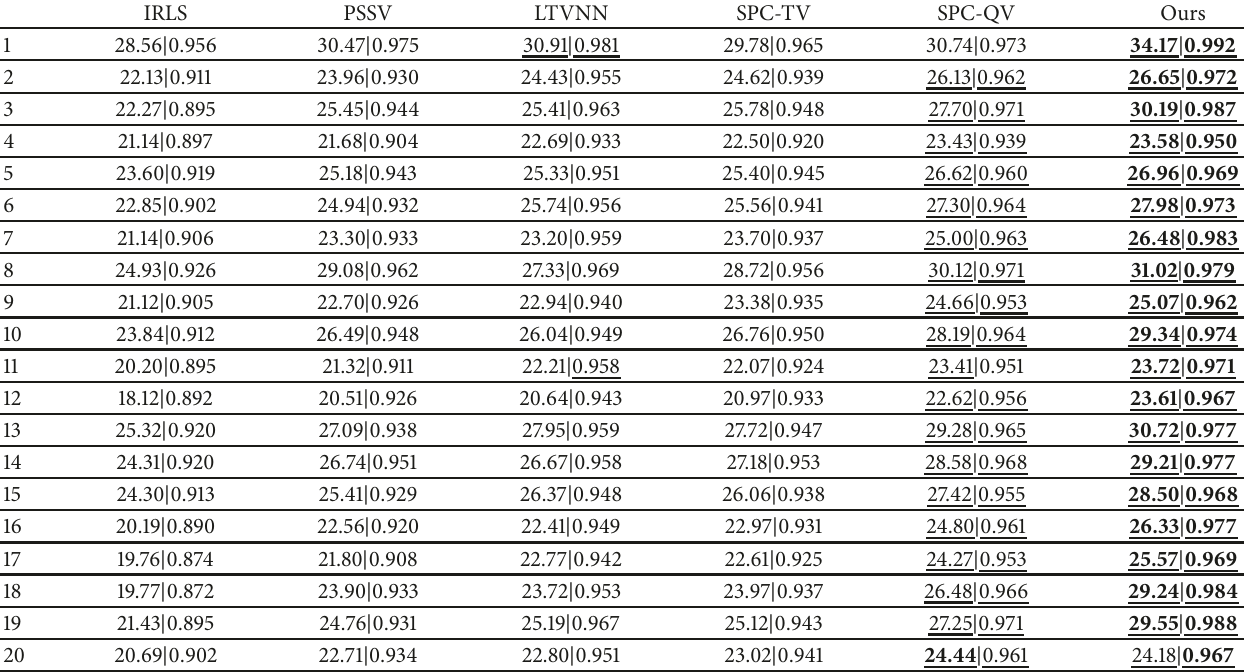
Figure 8: The desired text masked images. They are numbered in the same manner as we stated in Figure 3. Table 3: PSNR | SSIM results on reconstruction of 20 test images with text by different